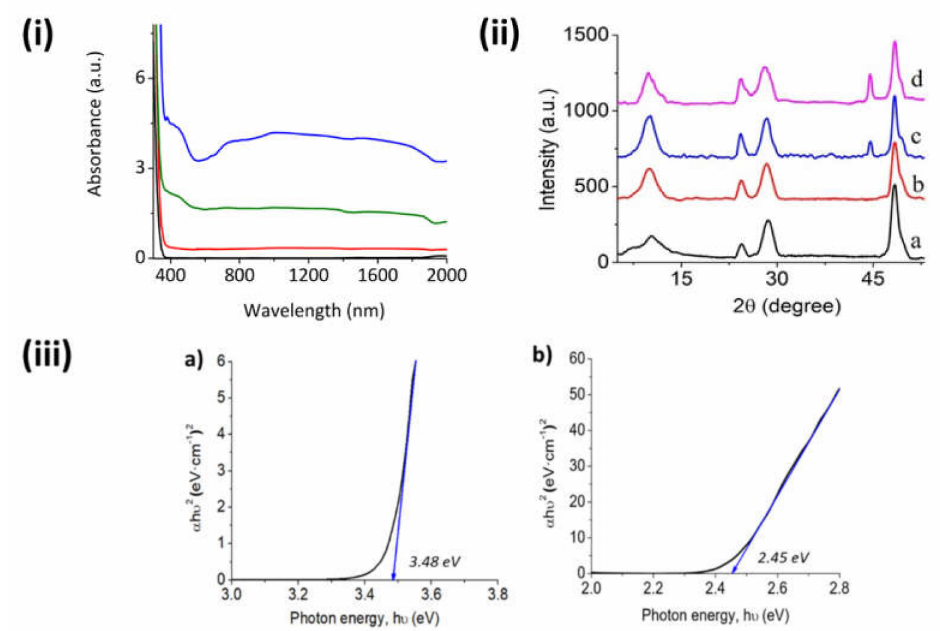
Figure 1. ( i ) Absorption spectra of UV–VIS–NIR acquired for Na,H / TiNT (black line), Ru / TiNT-0.5 (red line), Ru / TiNT-3.5 (green line), and Ru / TiNT-11 (blue line). ( ii ) X-ray powder di ff raction spectra of (a) Na,H / TiNT, (b) Ru / TiNT-0.5, (c) Ru / TiNT-3.5, and (d) Ru / TiNT-11; RuO 2 (rutile) (JCPDS-40-1290). ( iii ) Tauc plot assuming a direct band gap for the semiconductors ( a ) Na,H / TiNT and ( b ) Ru /